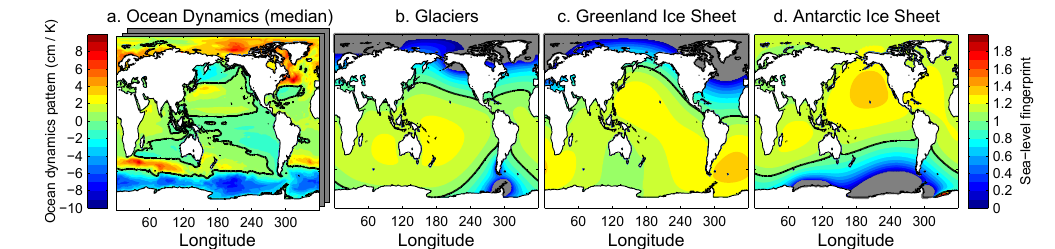
Fig. 5. (a) Sea level fingerprints for ocean dynamics (median), (b) mountain glaciers and ice caps, (c) GIS and (d) AIS, expressed in unit of regional sea level rise per unit of global mean temperature change (a) or global mean contribution of the source used for scaling (b–d) . Note that only the median of the 20 temperature-dependent ocean dynamic anomaly patterns is shown in (a) . All of the 20 patterns, as derived from CMIP5 GCMs, are shown in Fig. S2 in the Supplement. The ocean dynamic pattern in (a) is scaled by temperature projections and then added to the global mean thermal expansion (see main text) while mass additions from land ice are used to scale the gravitational patterns. The thick black line corresponds to the global mean on all maps, and grey shading indicates areas of sea level